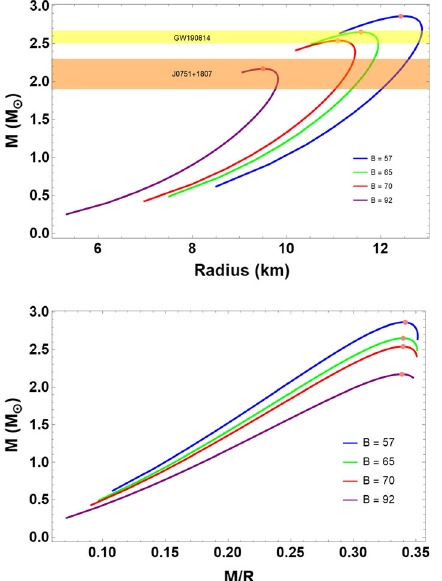
Fig. 2 Mass–radius ( M − R ) relation and compactness M − M / R of QSs have been plotted for λ = 4 . 5 MeV, m s = 50 MeV, (cid:16) = 120 MeV and different values of B = { 57 , 65 , 70 , 92 } MeV/fm 3 . The horizontal bars correspond to the constraints imposed by the GW 190814 event (yellow)[35]andPSRJ0751+1807(orange)[36].Eachcolorrepresents a different M − R relation with parameters mentioned in Table 2